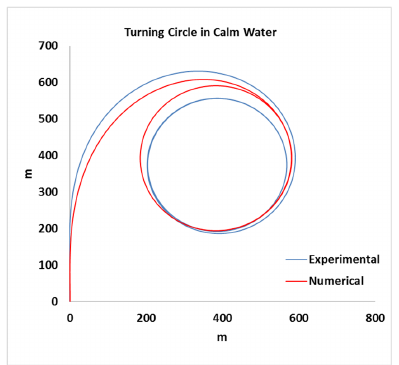
Figure 9. KCS’s experimental and numerical starboard-side 35 deg turning trajectories in calm water.